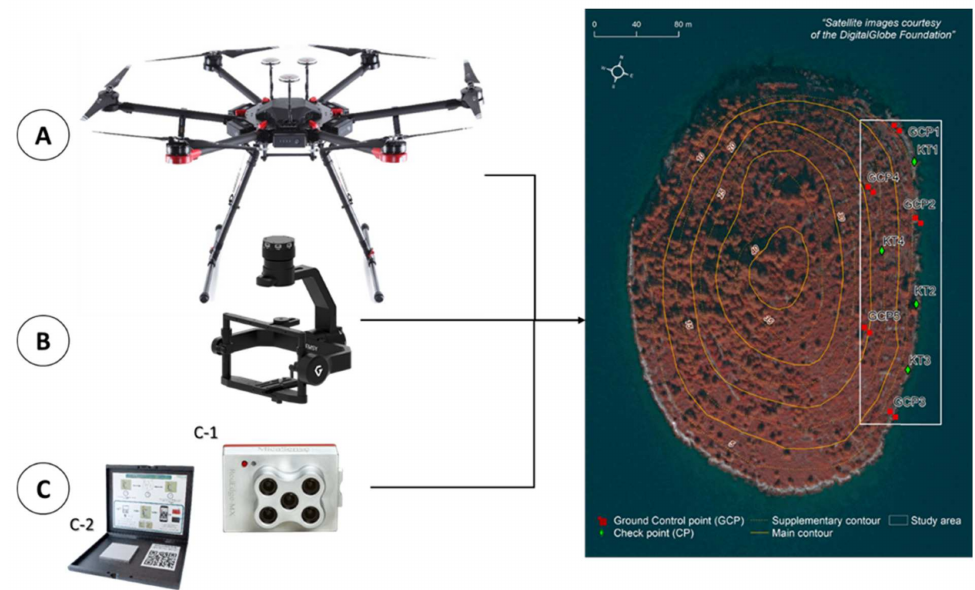
Figure 4. Different components ( A , B , C-1 , C-2 ) functionally integrated into MAPS ( left ); spatial extent of the multispectral UAV photogrammetric survey ( right ).